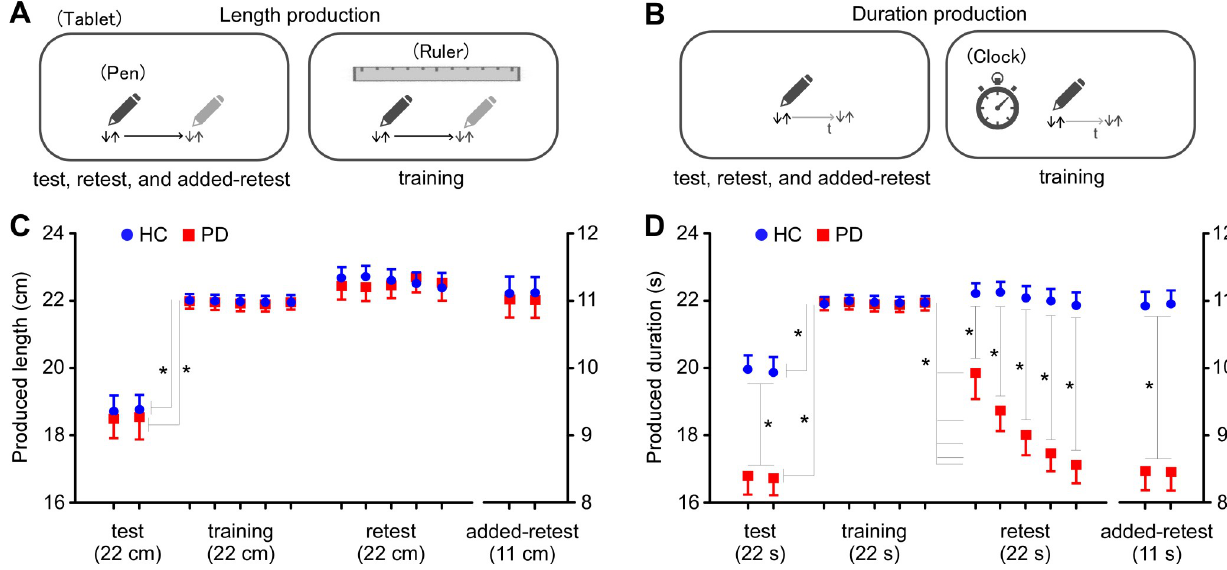
Fig 2. Estimation training task. ( A ) Line length was estimated by drawing a line with a pen without a cue in the test, retest, and added-retest sessions (left), and with a ruler cue in the training session (right). ( B ) Time duration was estimated by tapping the tablet with a pen without a cue in the test, retest, and added-retest sessions (left), and with a clock cue in the training session (right). ( C ) The estimated lengths did not differ between healthy controls (HC) and patients with Parkinson’s disease (PD) in any session. However, there were differences in performance between the second test and first training session in both HCs and patients with PD. ( D ) Estimated durations differed between the HC and PD groups in the test, retest, and added-retest sessions. Performance differed between the average of the test session and the first trial of the training session in both the HC and PD groups. Furthermore, the last trial of the training session differed from all trials in the retest session in the PD